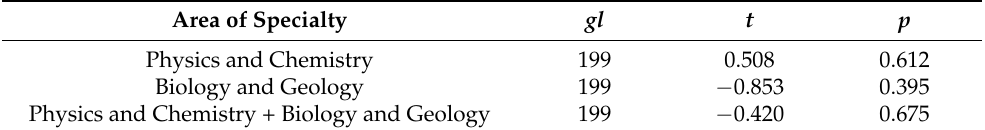
Table 2. Comparison of the score obtained in food myths by the participants of ‘Biology and Geology’ and ‘Physics and Chemistry’ with the rest of the areas through t-contrasts for independent samples. Area of Specialty gl t p Physics and Chemistry 199 0.508 0.612 Biology and Geology 199 − 0.853 0.395 Physics and Chemistry + Biology and Geology 199 − 0.420